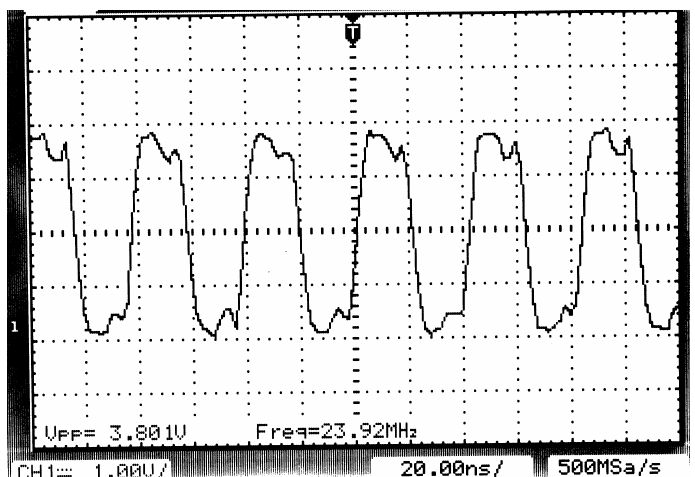
Oscilloscope image of the shared clock waveform as received into each DAQ module. The moderate overshoot and edge slopes contribute to a reduction of electromagnetic interference (EMI) due to